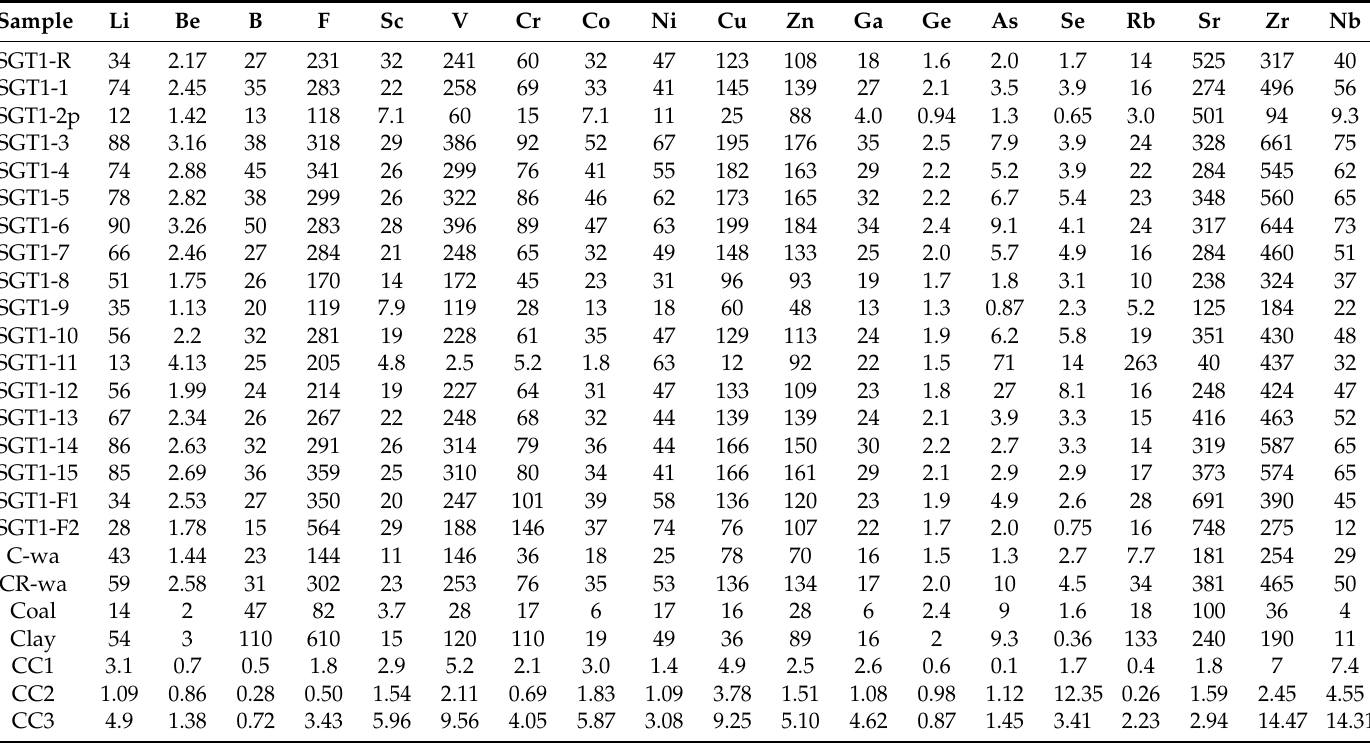
Table 3. Trace elements (ppm) in the Shugentian coal, carbonaceous rock, roof and floor